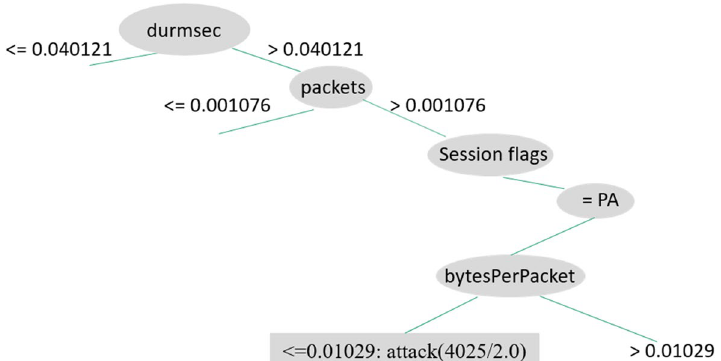
Fig. 6 Normalized C4.5D tree branch